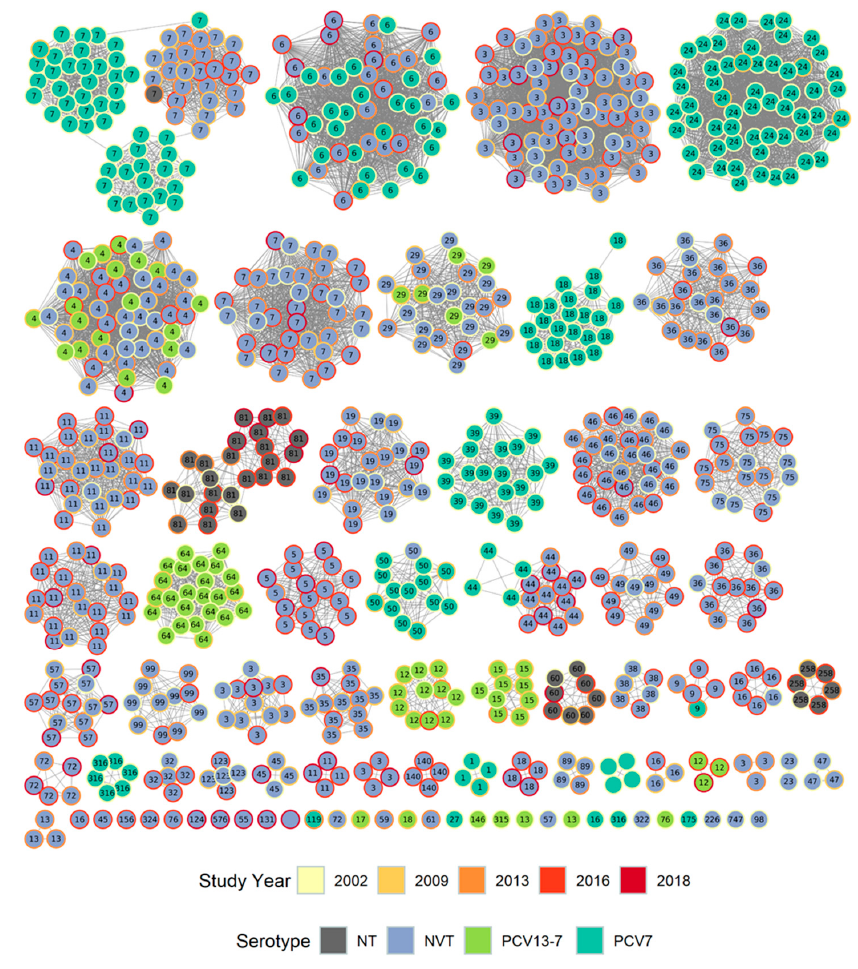
Figure 2. Cytoscape diagram of local PopPUNK clusters colored by vaccine serotype (inner fill) and by year (outer circle), labelled by the corresponding Global Pneumococcal Sequencing Cluster (GPSC) number.